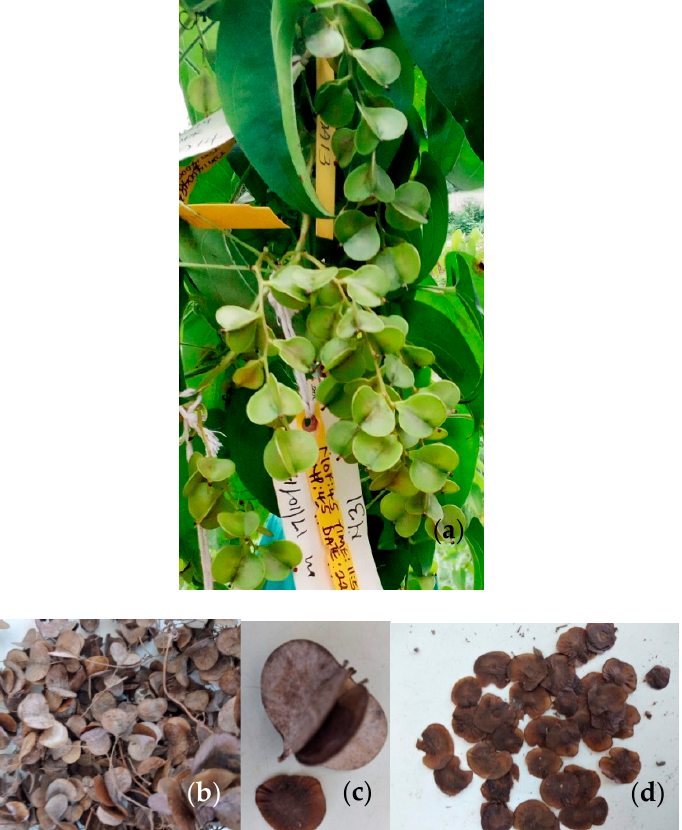
Figure 4. D. rotundata yam fruits and seeds: ( a ) Mature green fruits, ( b ) Dry fruits, ( c ) Dehisced dry fruit and released seed, ( d ) Dry winged seeds.